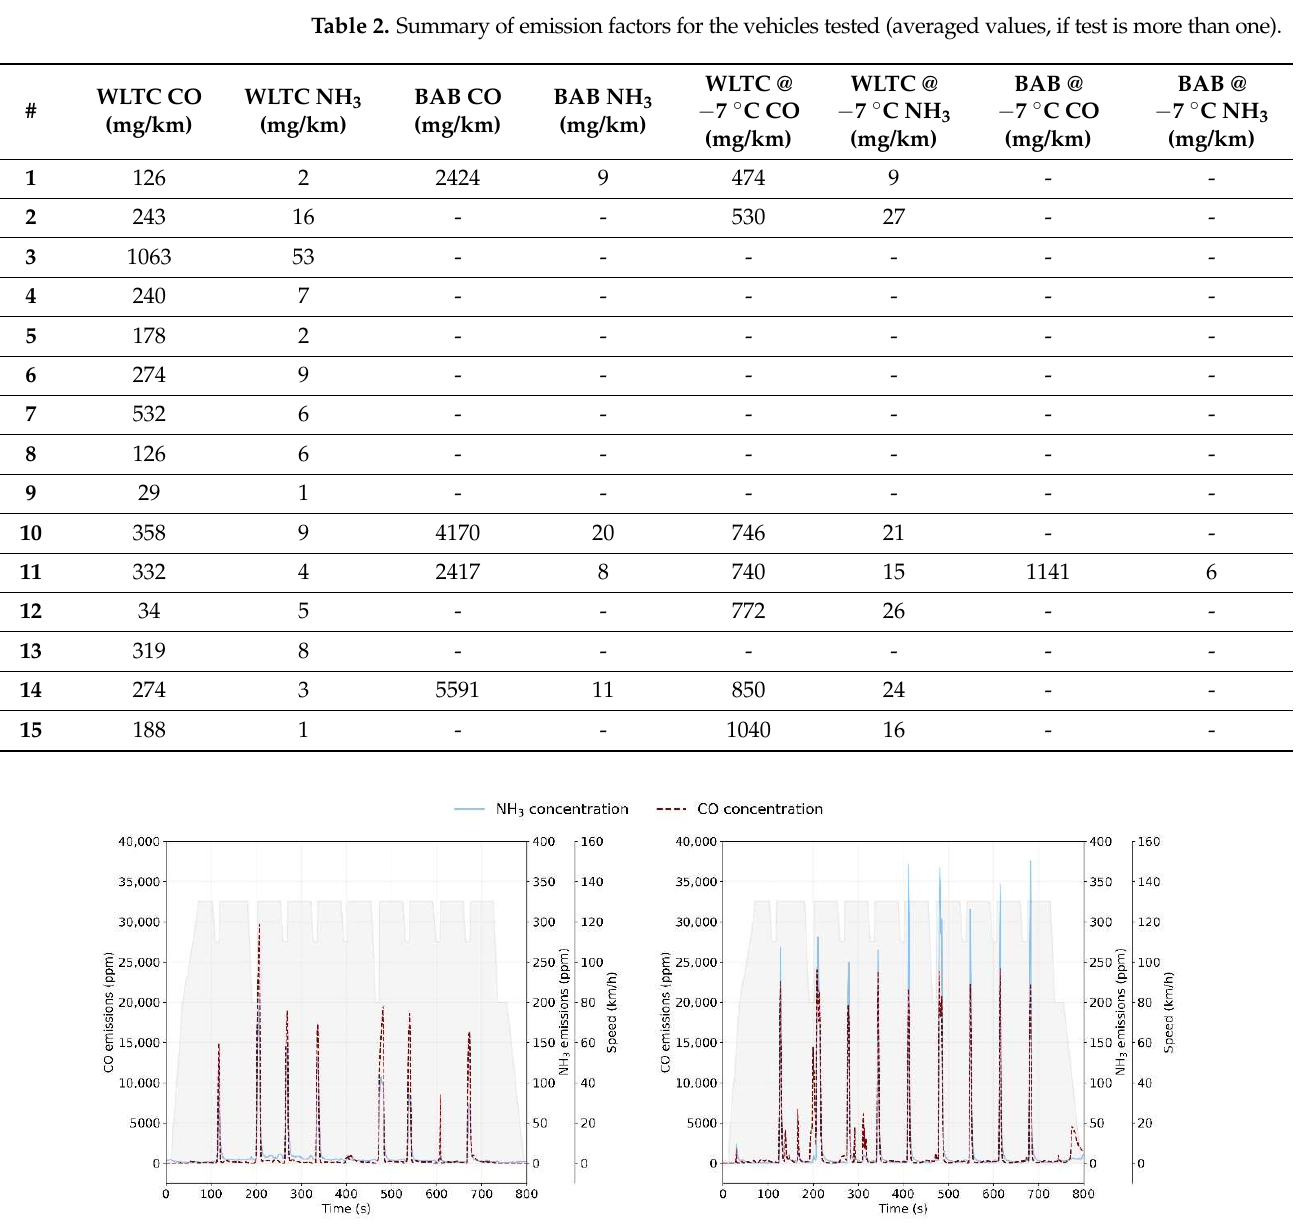
Figure 6. Examples of emission profile of NH 3 (light blue lines) and CO (red line lines) during a BAB. Left panel: vehicle #1; right panel: vehicle #10. Speed profile reported in grey.